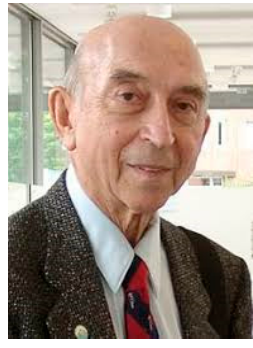
Figure 2. L.A. Zadeh (1921–2017).